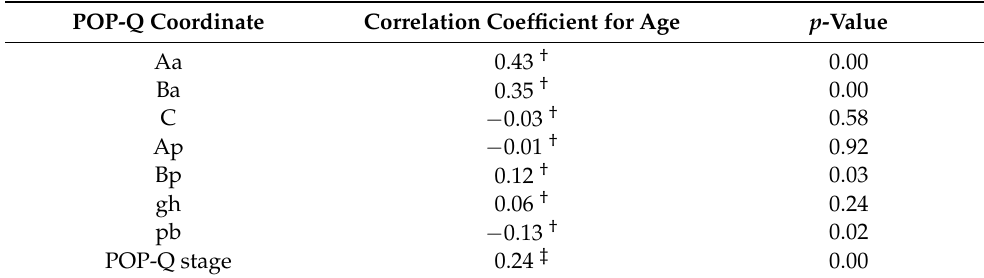
Table 3. Correlation between age and pelvic organ prolapse quantification (POP-Q) system points. POP-Q Coordinate Correlation Coefficient for Age